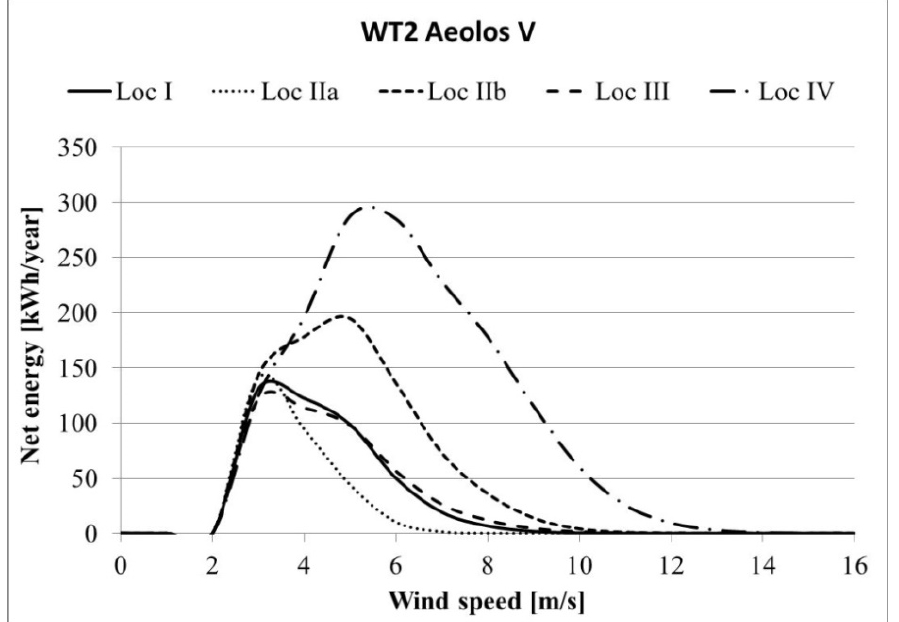
Figure 12. Amount of energy supplied to the power grid by the wind turbine as a function of the Table 2. Annual amount of energy delivered to the power grid by wind turbines . wind speed—WT2.